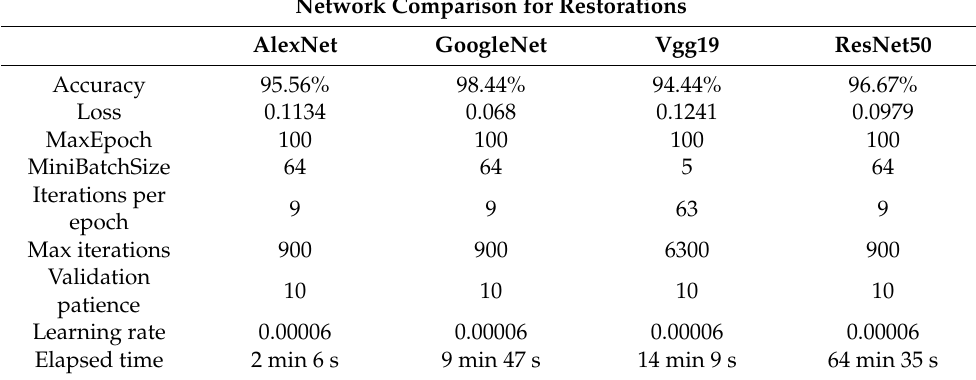
Table 11. Network comparison for